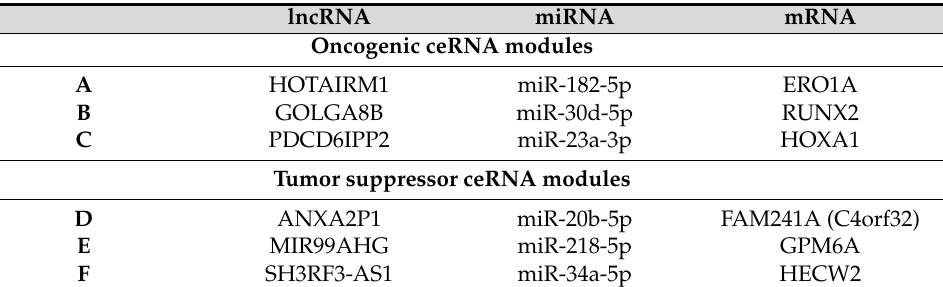
Table 1. The selected potential oncogenic and tumor suppressor ceRNA modules (lncRNA, miRNA, and mRNA).